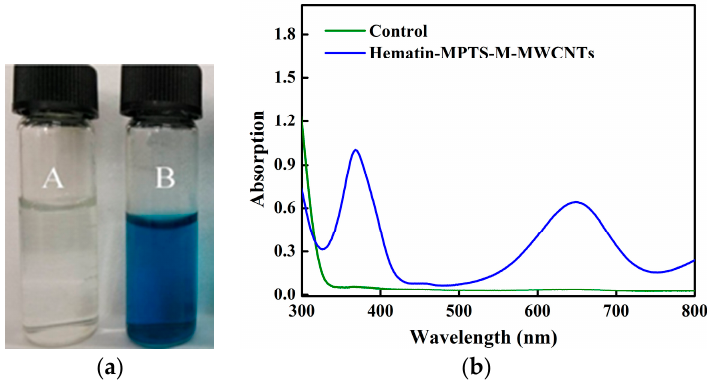
Figure 3. Oxidation of 3,5,3 ′ 5 ′‐ tetramethylbenzidine under the catalysis of hematin ‐ MPTS ‐ M ‐ MWCNTs. ( a ) Samples. A: H 2 O 2 (1 μ l/mL), TMB (0.02 mg/mL); B: H 2 O 2 (1 μ L/mL), TMB (0.02 mg/mL), hematin ‐ MPTS ‐ M ‐ MWCNTs (1 mg/mL). To observe to the color more clearly, hematin ‐ MPTS ‐ M ‐ MWCNTs in sample B was removed by centrifugation; ( b ) UV ‐ vis spectra.